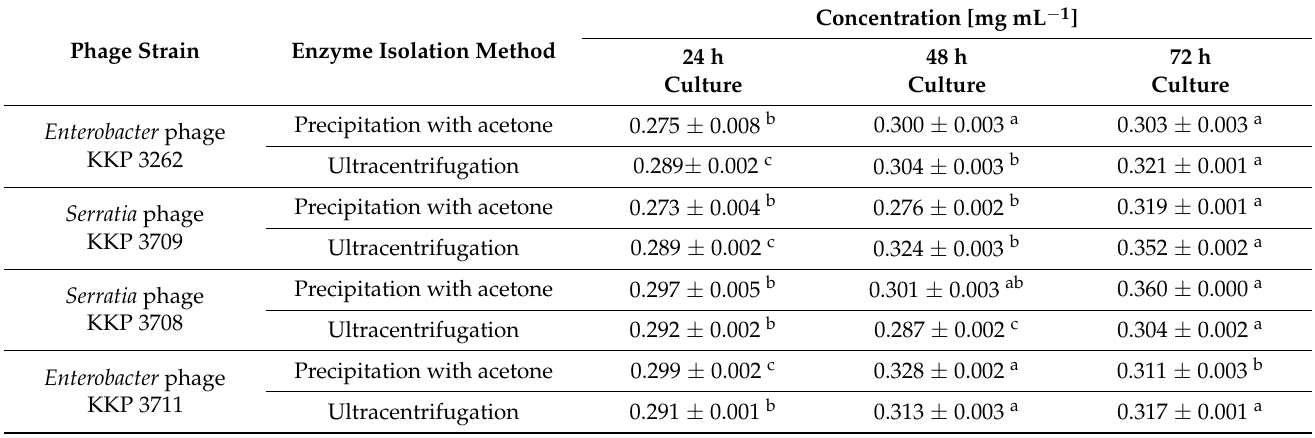
Table 3. Concentration of phage proteins in solution after